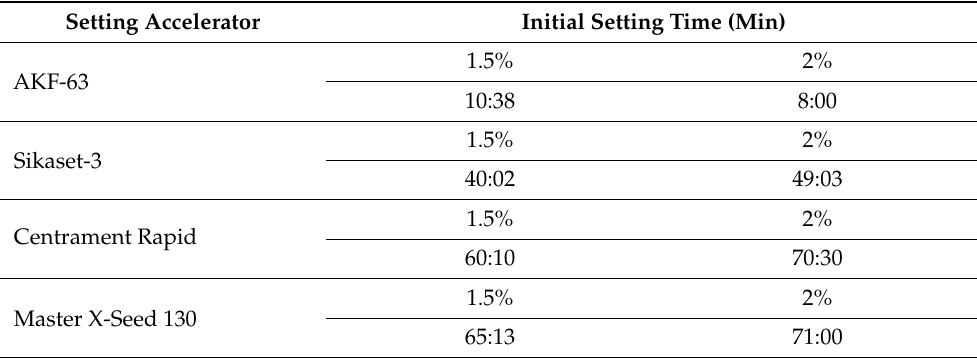
Table 4. Initial setting time of mortar with 1.5 and 2% setting